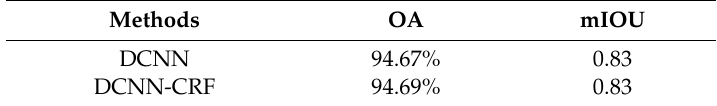
Table 3. Overall accuracy and mIOU of the segmentation results.